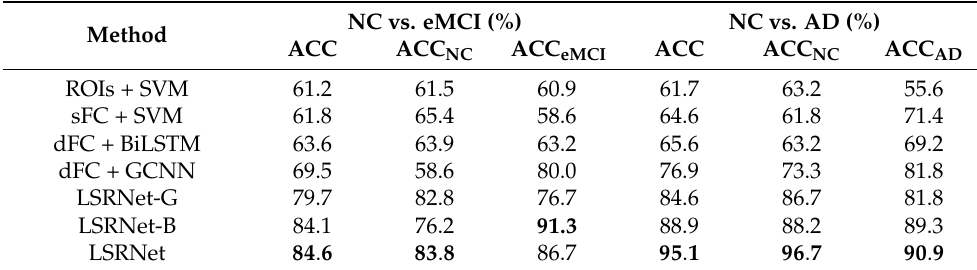
Table 1. Performance of the proposed method on partial metrics (NC vs. eMCT, NC vs. AD) on binary classification.